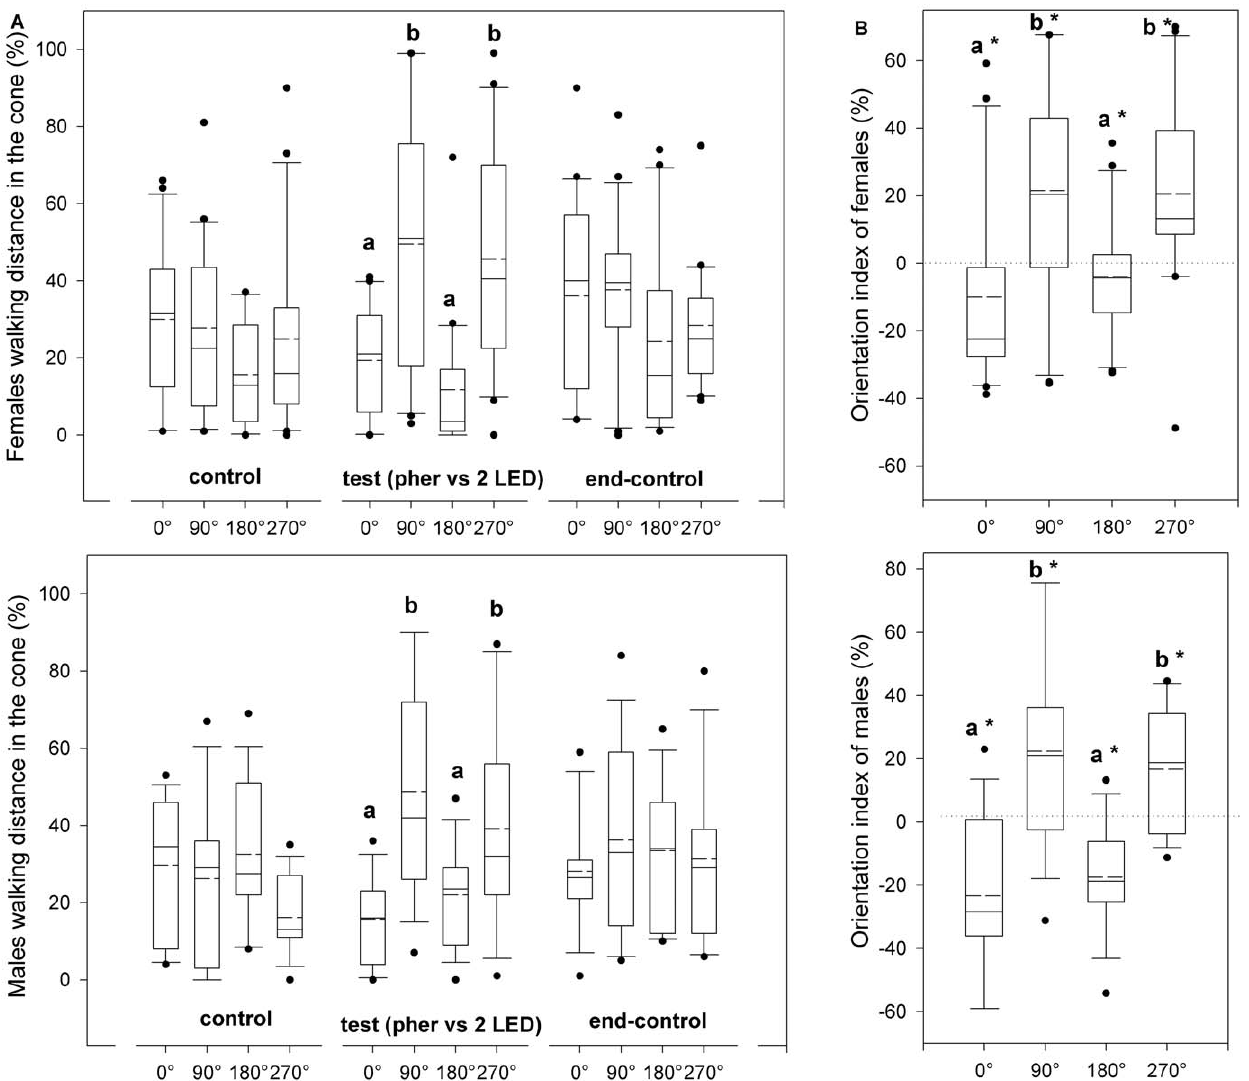
Figure 3. Orientation of Colorado potato beetle to light vs. aggregation pheromone. Orientation behaviors of female and male CPBs stimulated simultaneously with a male produced aggregation pheromone ( S )-CPB I in an air stream and two opposite LED beams of yellow light perpendicular to the air stream (pher vs. 2 LED). a. Proportion of distance covered during the three experimental periods (control, test and end- control) in each of four 120 u cones projected to 0 u , 90 u , 180 u and 270 u respectively. b. Orientation index calculated as the proportion of distance covered in each cone during the test period minus the proportion of the distance covered in each cone during the first control period. Asterisks (*) indicate means that are significantly different from zero (Wilcoxon signed rank test, p , 0.05). Different letters indicate significant pairwise differences across the different directions (Dunn’s post-hoc test, p , 0.05). In the boxplots, the line within a box mark the median, the segmented line within a box mark the mean, the lower and upper boundary lines of a box indicate the 25 th and 75 th percentiles, bars below and above indicate the 10 th and 90 th percentiles, respectively, and the points represent data beyond these limits. doi:10.1371/journal.pone.0020990.g003 the three different stimulus treatments (Fig. 6). The maximum speed levels during the end-control period (P . 0.05, Fig. 6a). When recorded (during photic stimulation) for females was 20.7 mm/s and considering classes categories separately, we also found significant for males 12.9 mm/s. Velocities of both sexes were increased speed differences between the initial control period and the end- significantly by each stimulus treatment (one-way ANOVA, P , 0.01). control period for females (paired t-test, P , 0.05), but not for males The velocities of both sexes decreased after most stimulus treatments, (P . 0.05). Insects walked faster during the test period when compared i.e. during the end-control period compared with the test period to the prior control period (i.e. speed indexes were significantly higher (Repeated measures ANOVA, P , 0.05), except for the speed of than zero, Fig. 5b). Speed indexes were significantly different between females for ‘pheromone alone’ that did not decrease (Repeated the three stimulus treatments (one-way ANOVA, p , 0.01); insects measures ANOVA, P . 0.05, Fig. 6a). Velocities were greater during walked faster during stimulation with pheromone plus yellow light the end-control period for all females treatments compared to the than with pheromone alone (Fig. 6a,b). Females walked faster than initial control period (Friedman’s ANOVA between the two control males during control, test and end-control periods (unpaired t-test, periods, P , 0.05), but velocities of males returned to pre-stimulation p , 0.05, Fig 6a,b).